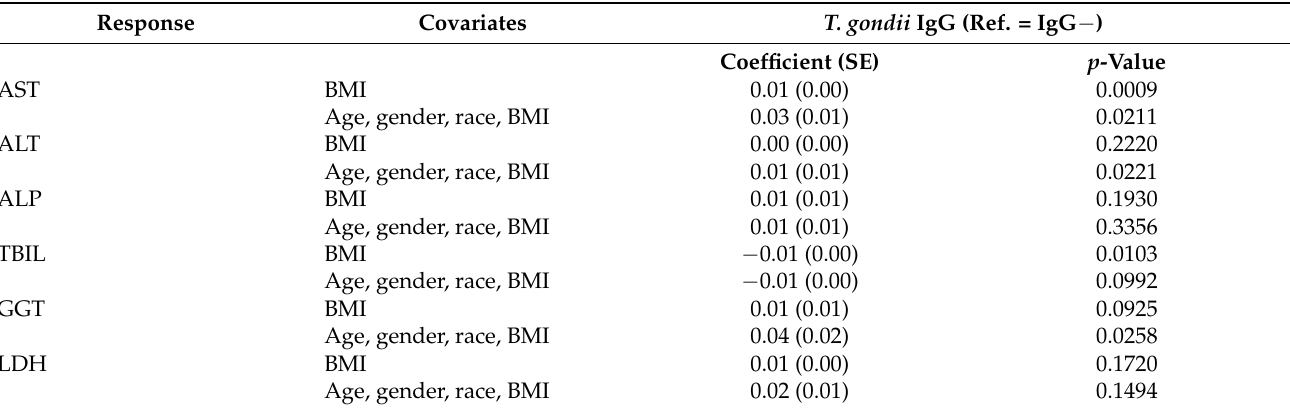
Table 3. Results of linear regression models for liver biomarkers and T. gondii IgG antibody—adjusted for demographic and anthropometric factors.